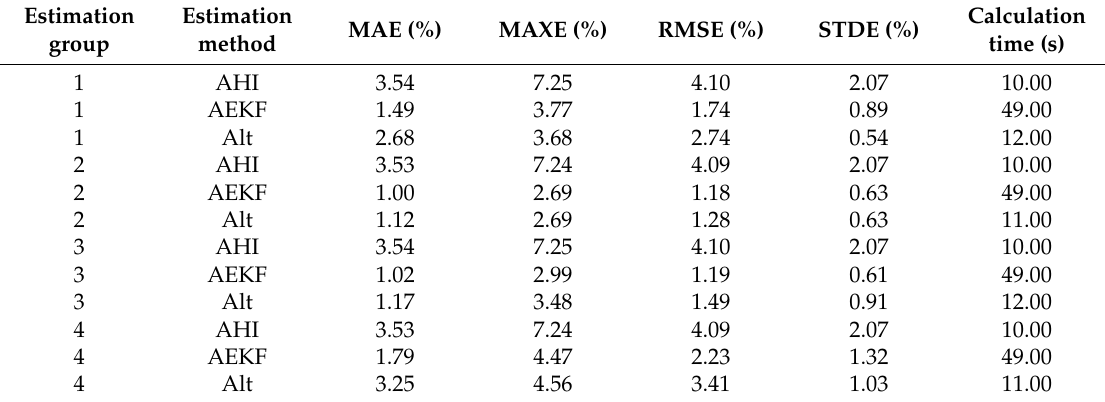
Table 4. SOC estimation errors and the time cost using different methods with voltage drifts and current